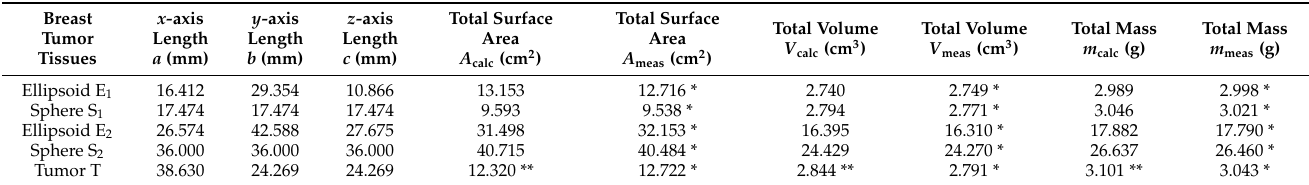
Figure 5. Analyzed scenarios of tumor shapes: ( a ) irregular tumor T, equivalent sphere S 1 , and equivalent ellipsoid E 1 have the same surfaces and volumes; ( b ) irregular tumor T is inscribed into sphere S 2 and ellipsoid E 2 with correspondingly larger volumes. Table 2. Geometric parameters for different shaped tumors studied.